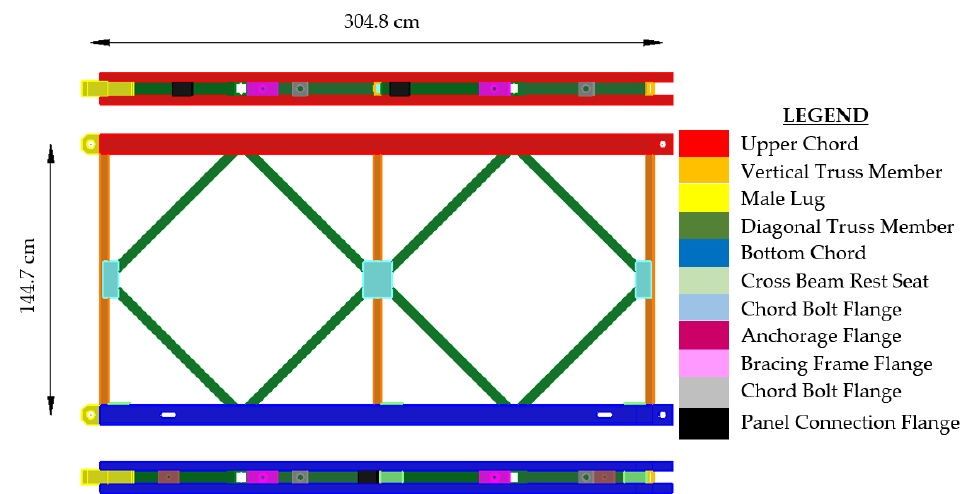
Figure 2. Typical M2 Bailey bridge panel (side view and plan views of chords).